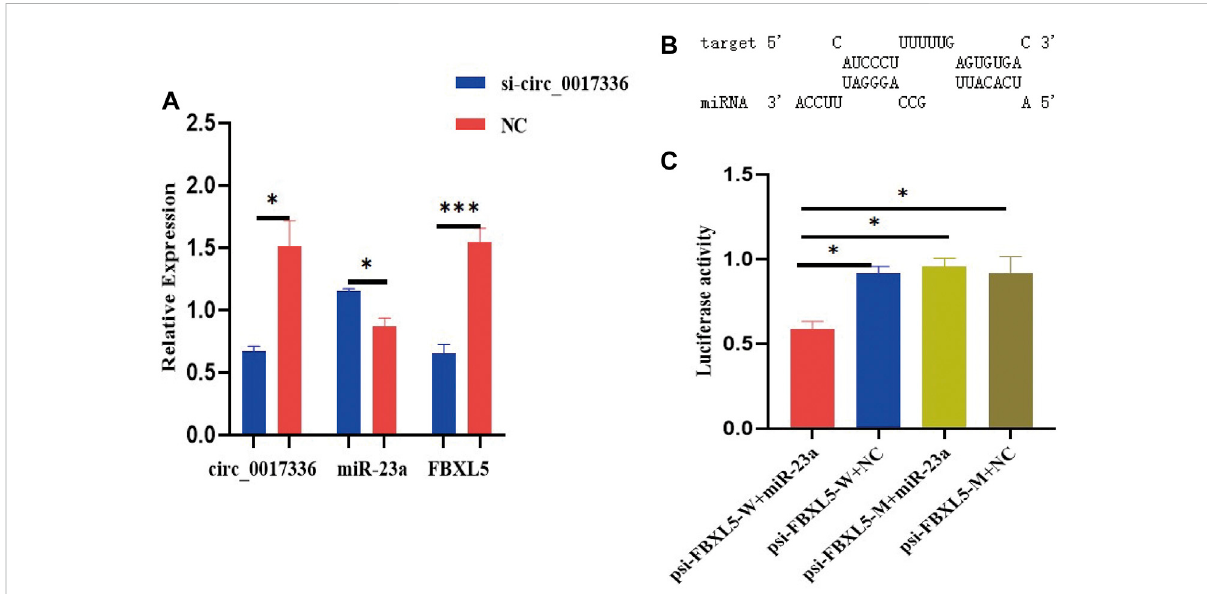
FIGURE 9 (A) si-circ_0017336 promotes the expression of miR-23a and inhibits the exprsion of FBXLS in sheep myoblasts. (B) . The binding sites of miR- 23a and FBXLS were predicted by RNAhybrid software. (C) Dual-luciferase reporter gene experiments veri fi ed that miR-23a directly targets FBXL5. indicates p < 0.05, ***indicates p < 0.001, NC is the control